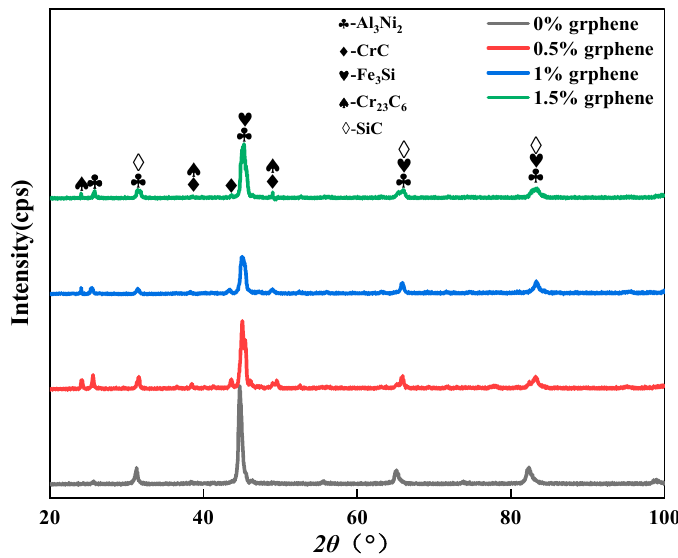
Figure 3. The phase composition of the cladding layer.